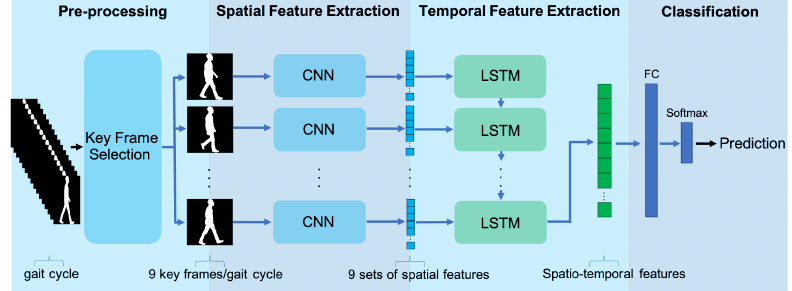
Figure 1. Architecture of the proposed spatiotemporal deep learning framework for pathological gait classification. In the figure, the same CNN is repeated multiple times for illustrative